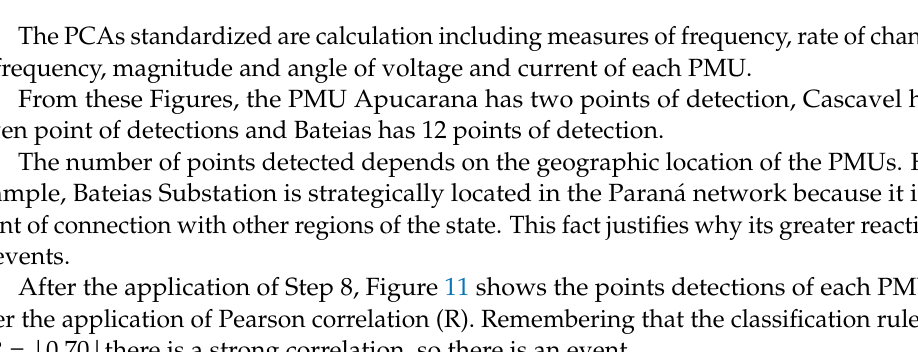
Figure 10. Event 1: detector event of PMU Bateias (located at Parana State).